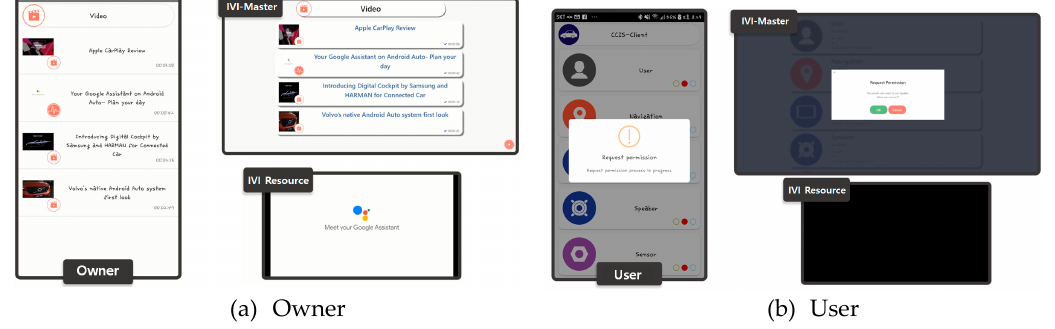
Figure 19. Personal resource control by owner and user.